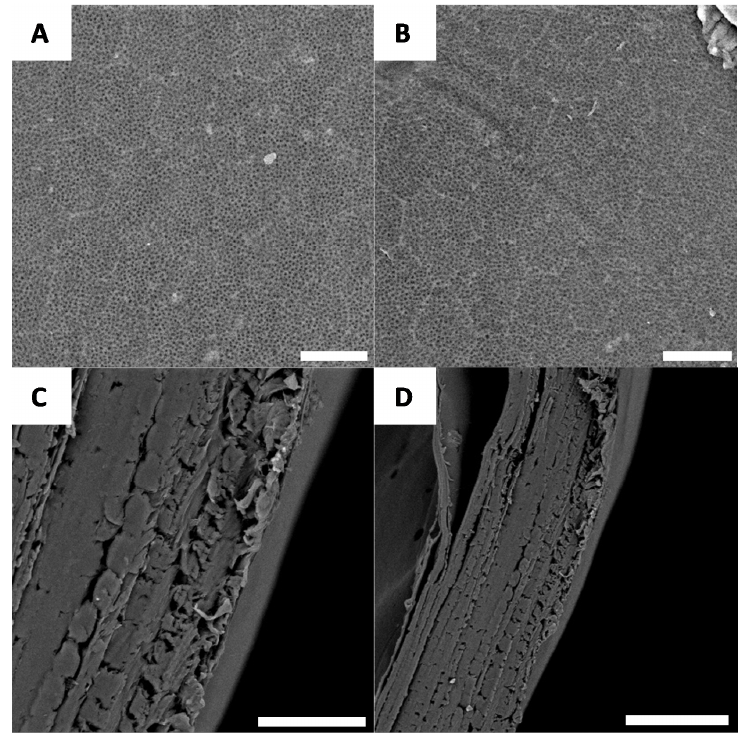
Figure 8. Examples of morphology observed for G. orientalis chitosan ( A and B ) (Scale bar = 10 µm); Cross-section observations for G. orientalis chitosan ( C and D ) (Scale bar = 80 µm).